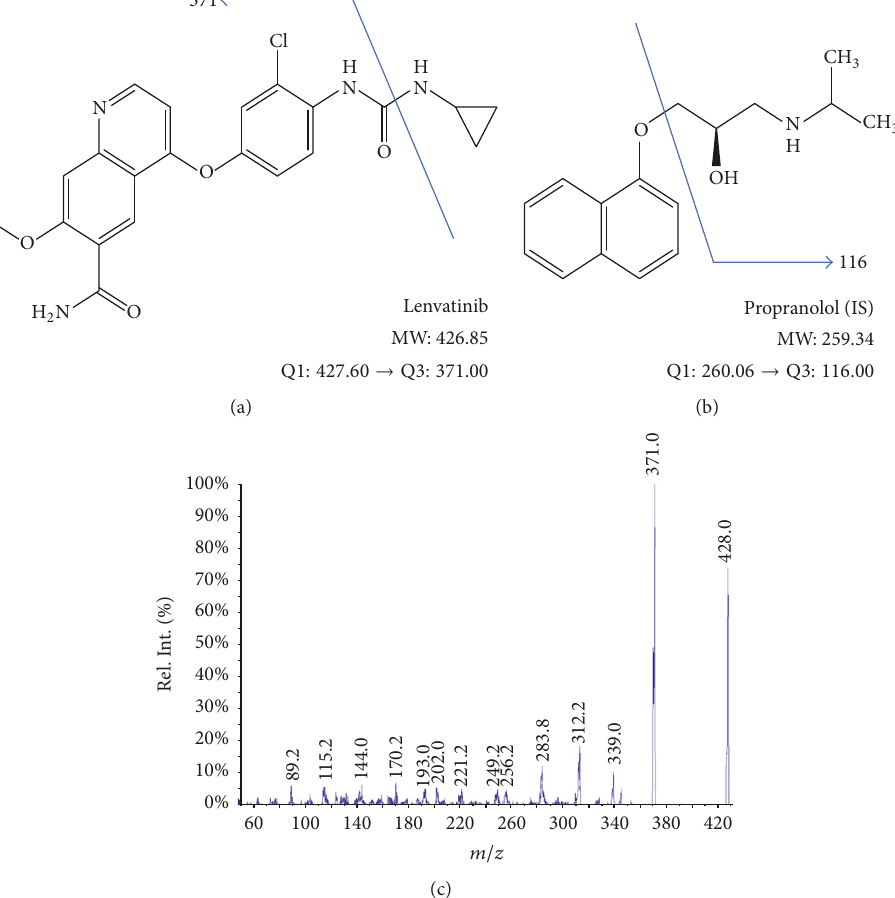
Figure 1: Chemical structures of lenvatinib and propranolol as an internal standard. Product ion mass spectra of lenvatinib. Chemical structure of lenvatinib (a) and propranolol (b) as an internal standard. (c) Product ion spectrum of lenvatinib at a precursor ion 𝑚/𝑧